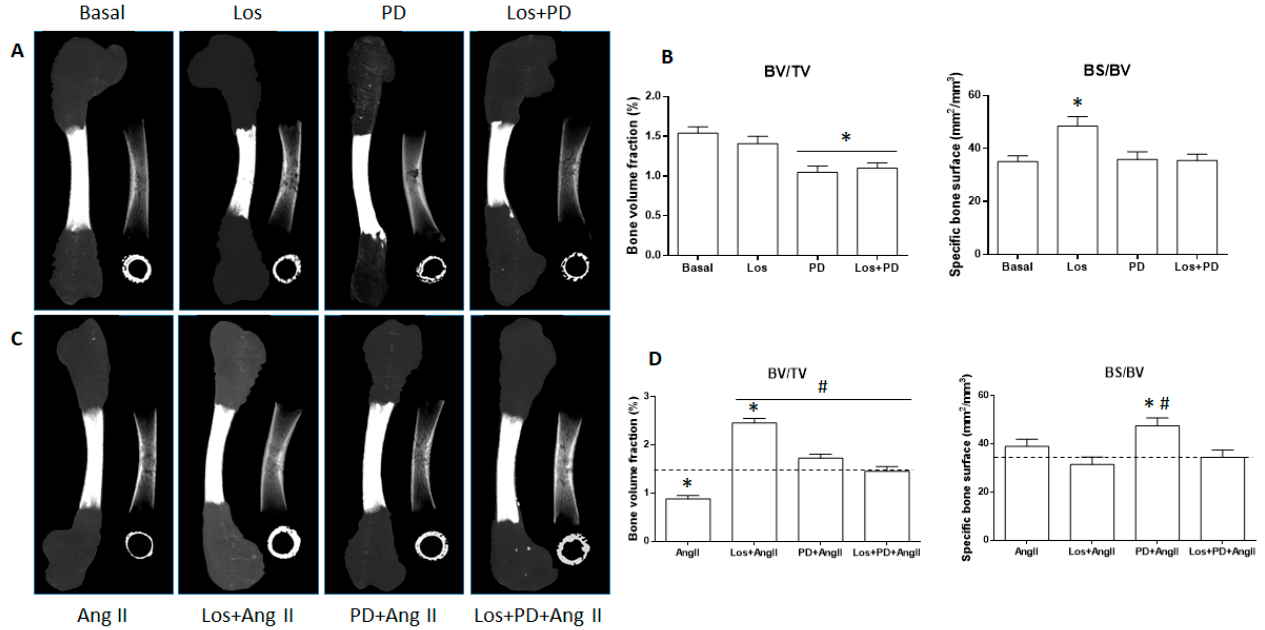
Figure 2. Microcomputed tomography images of the whole femur tissue region (segmented mineralized bone, sagittal and cross-sections of the central diaphysis region) and morphometric indices (BV/TV and BS/BV) of ED11 chick femurs following 11-day organotypic culture in conditions of AngII/AT1R/AT2R axis modulation. ( A , B ): basal conditions, and following receptor blockade; ( C , D ): exposure to AngII, and receptor blockade prior to the addition of AngII. Los: Losartan; PD: PD123319. * Statistically different from basal conditions; # statistically different from AngII; ( p ≤ 0.05).